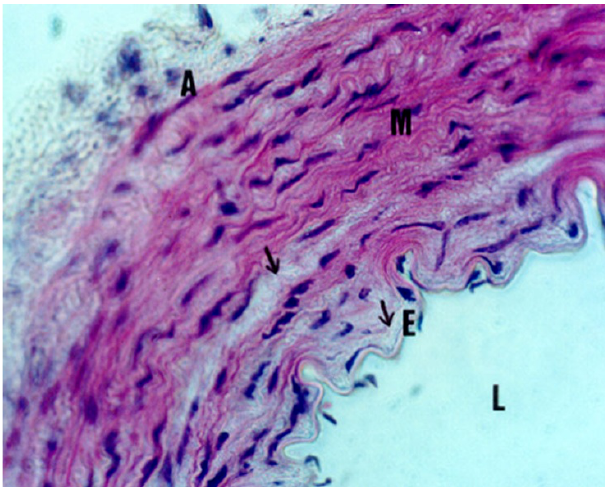
Figure 2 Aorta of a high cholesterol diet animal (400 × ). Arrows indicate spaces within intima tunica and within media